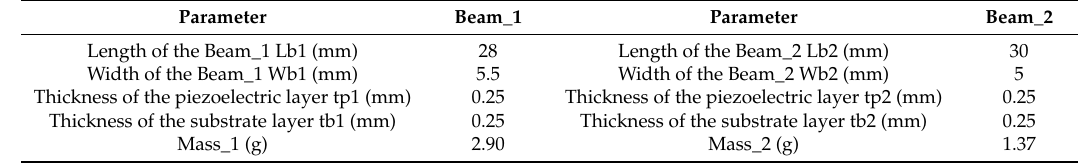
Table 2. The dimensions of the micro wideband piezoelectric vibration energy